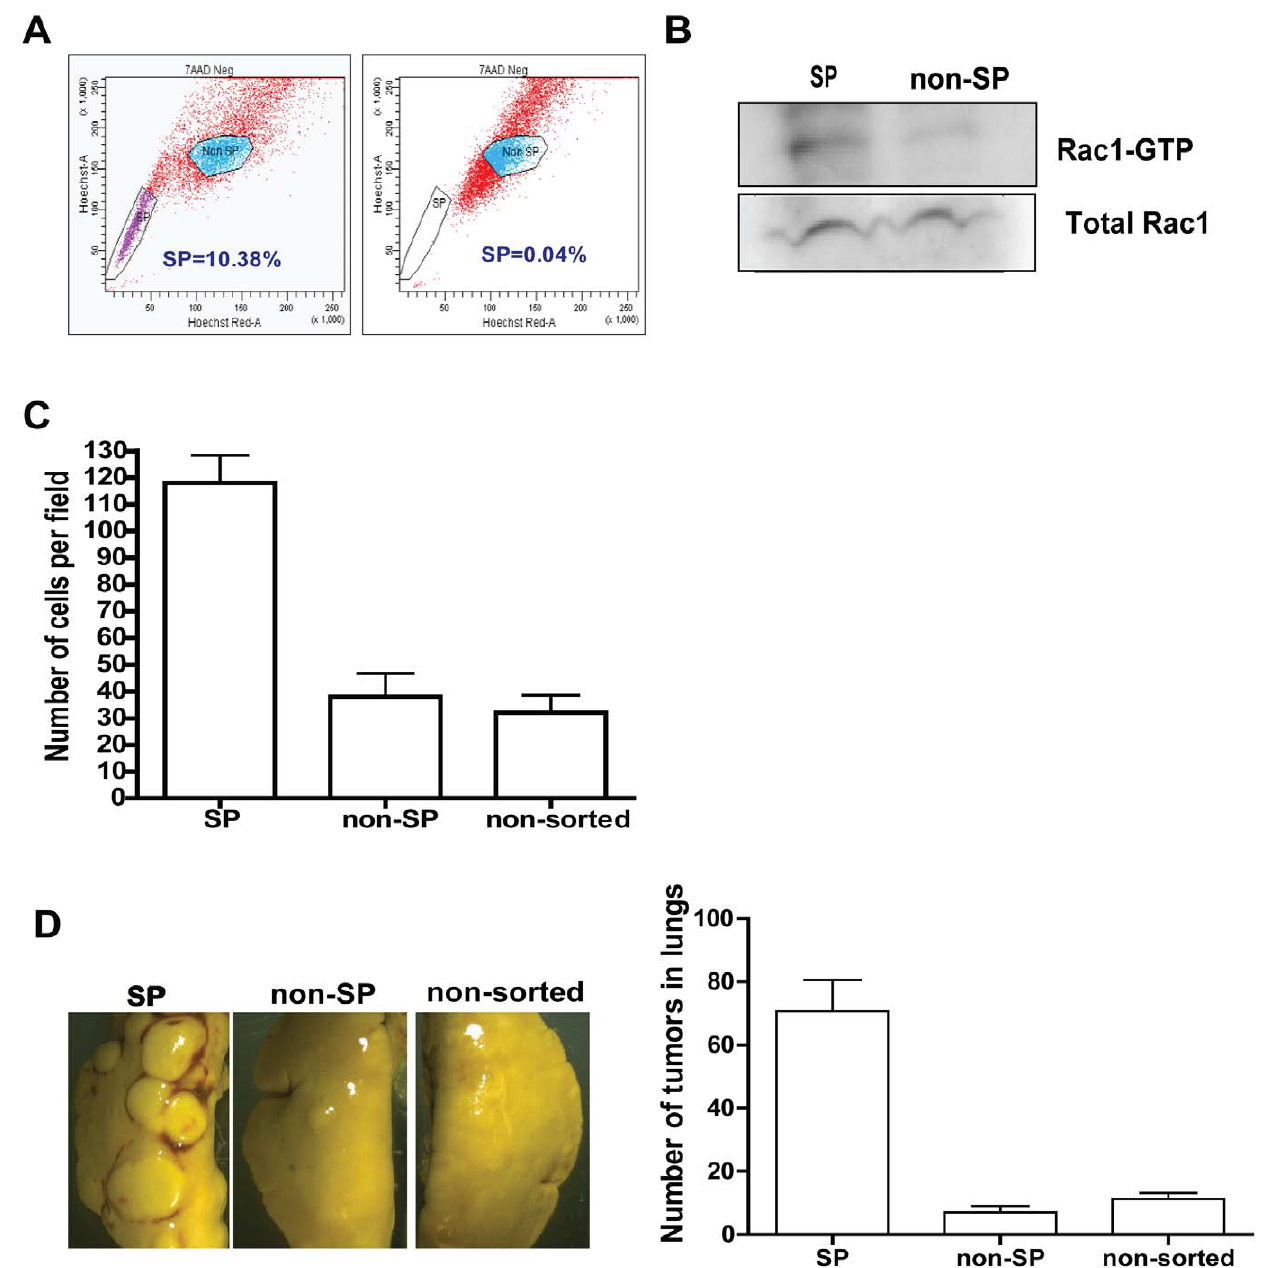
Figure 4. Side population cells possess elevated Rac1 activity, increased migration, invasion and proliferative activities, and enriched tumor initiating activity in mouse lung. (A) A549 cells were stained with Hoechst 33342 dye and analyzed by flowcytometry for side population (left panel). Cells were treated with 10 m M Fumitremorgen for inhibitor control (right panel). Depicted is a representative of several SP analyses. (B) Cell lysates collected from sorted SP and non-SP cells were subjected to GST-PAK pull down assay and processed for Rac1 western blot analysis to determine the Rac1 activity. Total Rac1 blot was used as a control. Depicted is a representative of three independent Rac1 activity pull- down assays. (C) Sorted A549 cells were plated for trans-well migration assay and cells migrated overnight towards 10% FBS were stained and counted. Above is a representative of three independent experiments and error bars represents SD. (D) 5 6 10 4 sorted SP and non-SP cells were injected into tail vein of NSG mice (n=4 per condition). Lungs were dissected out at the end of 12 weeks. Right panel shows quantification of lung colonization data. Error bar represents SE. Above is a representative of three independent experiments. doi:10.1371/journal.pone.0016951.g004 Rac1 knockdown in both SP and non-SP cells (Fig. S5A). In line Consistently, the adhesion activity of both SP and non-SP cells to with our earlier data on parental cells, Rac1 knockdown altered fibronectin was also decreased (Fig. 5B). Further, Rac1 knockdown the cytoskeletal organization of both SP and non-SP cells (Fig. decreased migration and invasion of both SP and non-SP cells S5B), and reduced focal adhesion complexes as visualized by p- (Fig. 5C, 5D). Thus, Rac1 targeting can suppress migration and FAK immunostaining of both SP and non-SP cells (Fig. 5A). invasion of both SP and non-SP cancer cells.